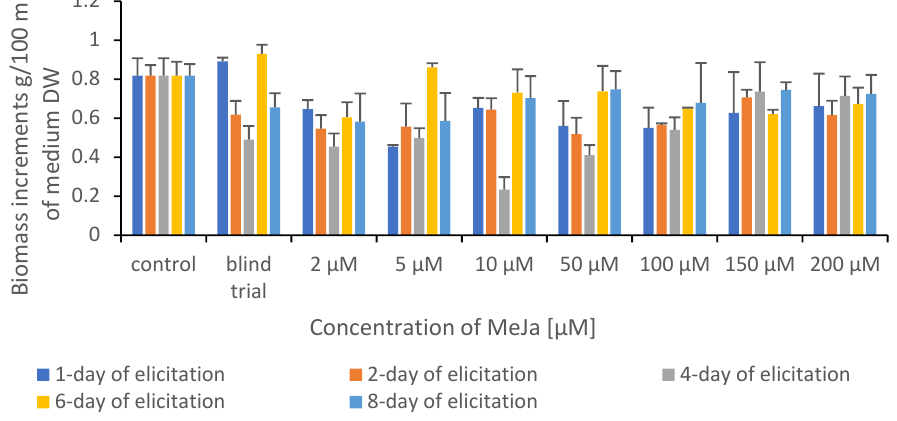
Figure 2. Comparison of biomass increment values of control and experimental cultures of Ganoderma applanatum after